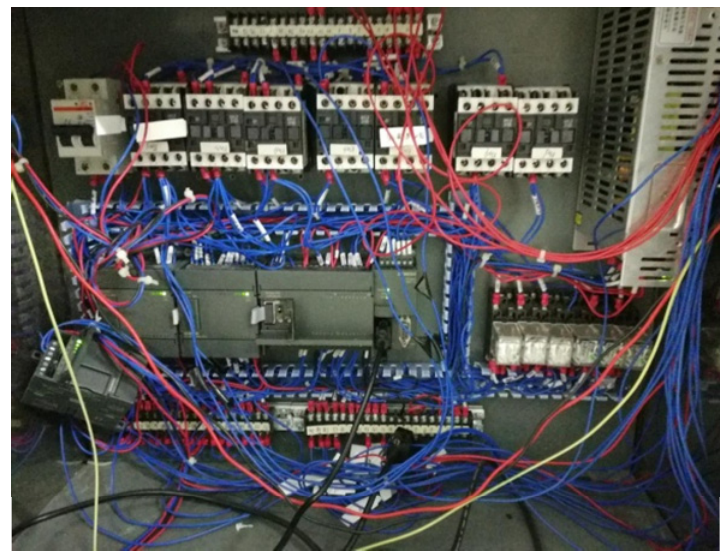
Figure 8. Physical connection picture of PLC.